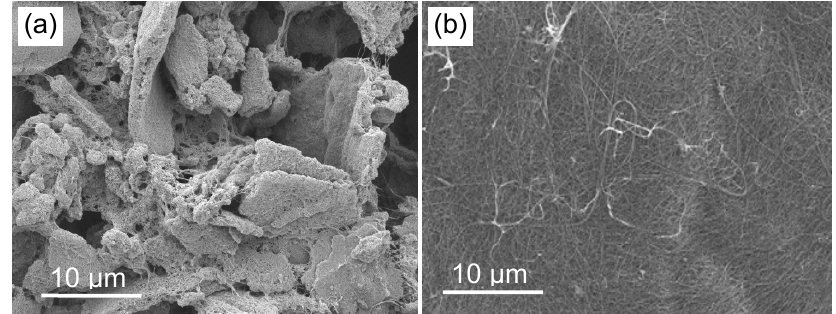
Figure 3. SEM image showing the surface of a Bucky-paper formed from (a) poorly dispersed single walled carbon nanotubes and (b) well dispersed CNTs (2 keV, 9 mm working